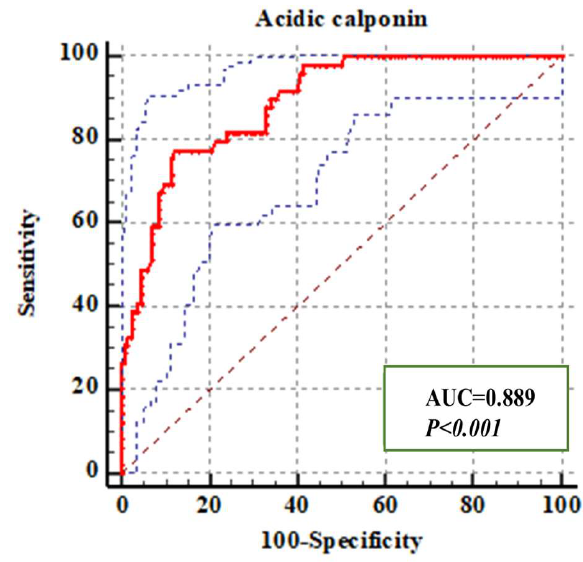
Figure 4. Acidic calponin levels in patients examined in the present study according to final diag- nosis.